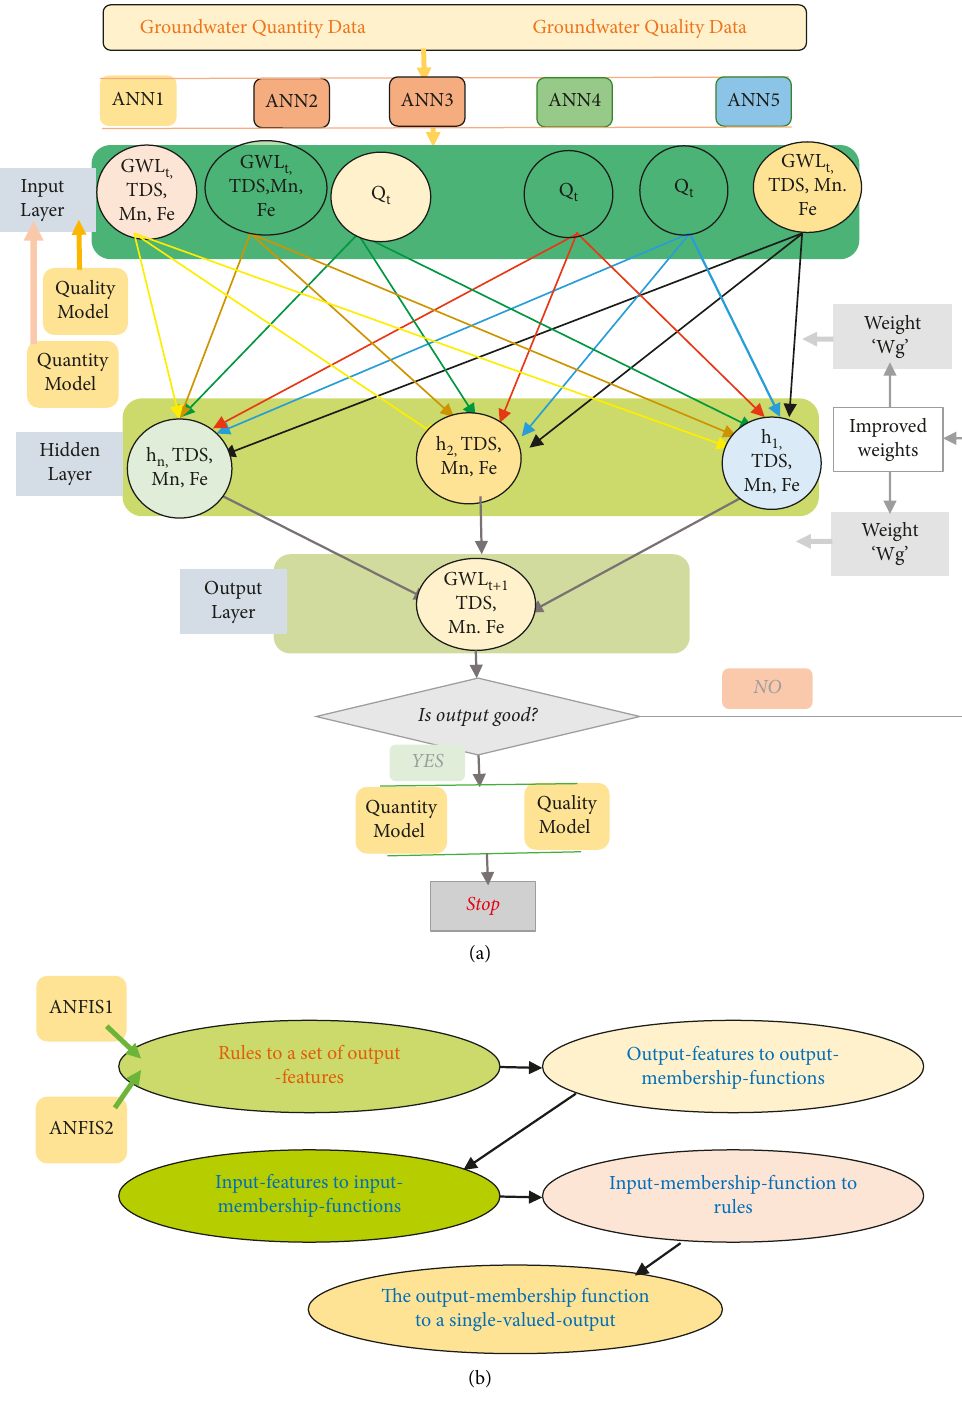
Figure 5: AI modelling approach. (a) Flowchart representing the MLP (a feedforward-ANN). (b) Five functional blocks in ANFIS. Table 4: Various training functions used for ANN